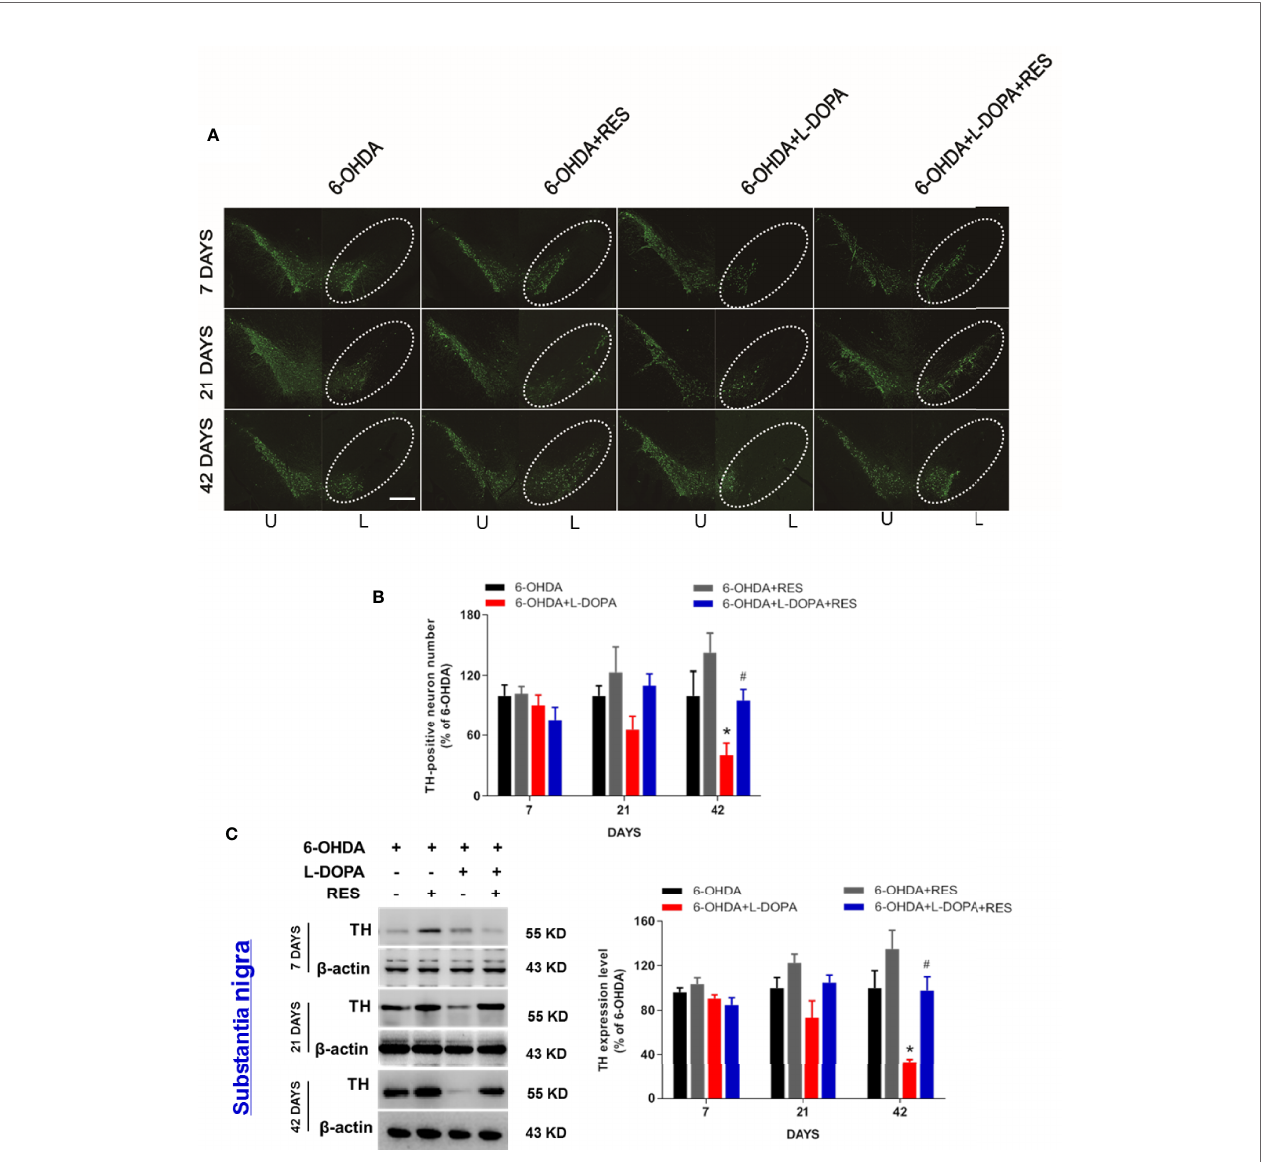
FIGURE 3 | Effects of RES combined with L-DOPA on 6-OHDA-induced DA neurotoxicity. 7, 21 and 42 days after L-DOPA treatment, rats were sacri fi ced and brains were collected, respectively. DA neurons in substantia nigra were recognized and immunostained with an anti-TH antibody (A) . The “ ellipse ” presented the area of substantia nigra. DA neuronal loss in substantia nigra was analyzed via the quanti fi cation of TH-positive neurons. U, unlesioned side; L, lesioned side. (B) . Scale bar=100 µm. TH protein level was determined by western blotting (C) . The densitometry values of TH were detected and normalized to b -actin of the same group. Then, data were normalized and calculated as a percentage of each respective 6-OHDA group. Data were expressed as mean ± SEM from 5 rats. * P < 0.05 compared with 6-OHDA group; # P < 0.05 compared with 6-OHDA+L-DOPA